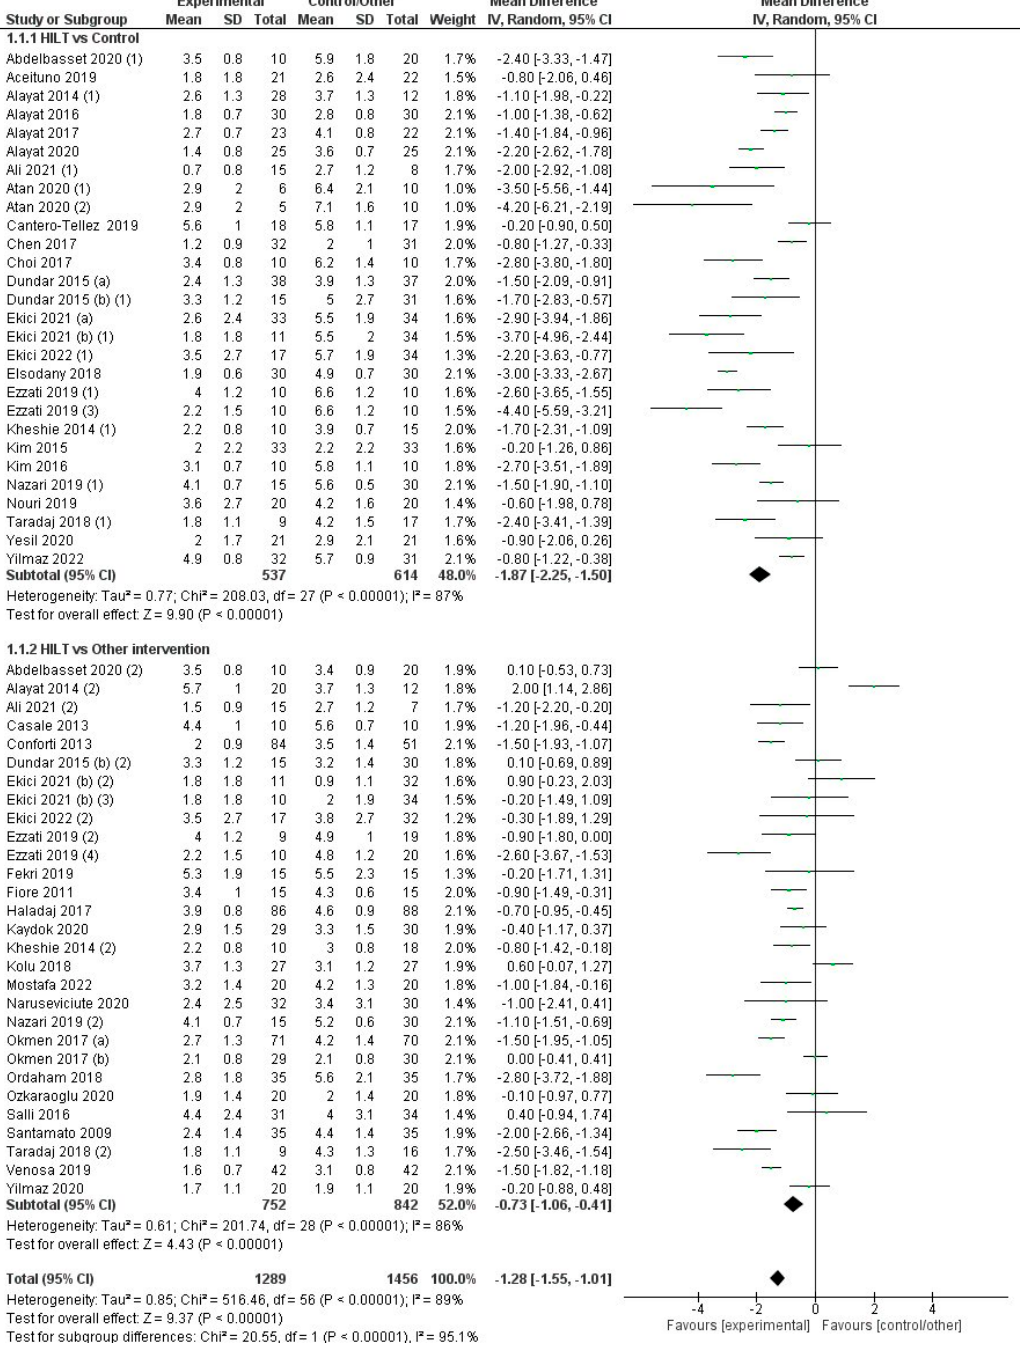
Figure 4. Forest plot for the overall effect on the pain VAS comparing high-intensity laser therapy (HILT) vs. control/another intervention and subgroup analysis depending on the comparator (HILT vs. control/HILT vs. another therapy). For studies with three arms: (1) Comparator: control or sham control. (2) Comparator: another therapy .